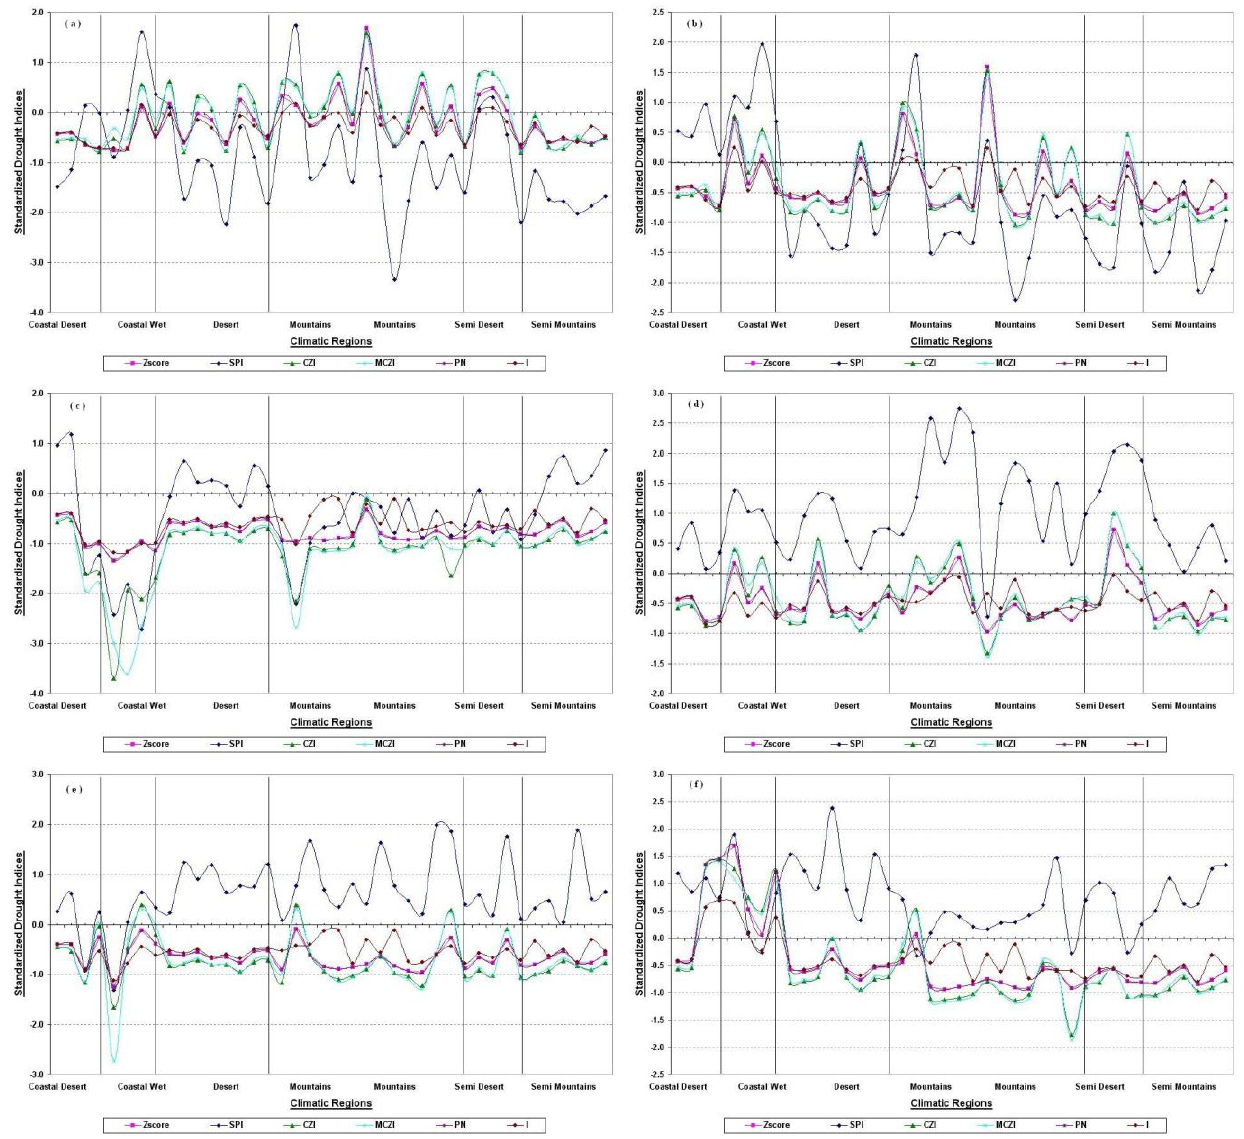
*X-axis represents study sites located in all six climatological